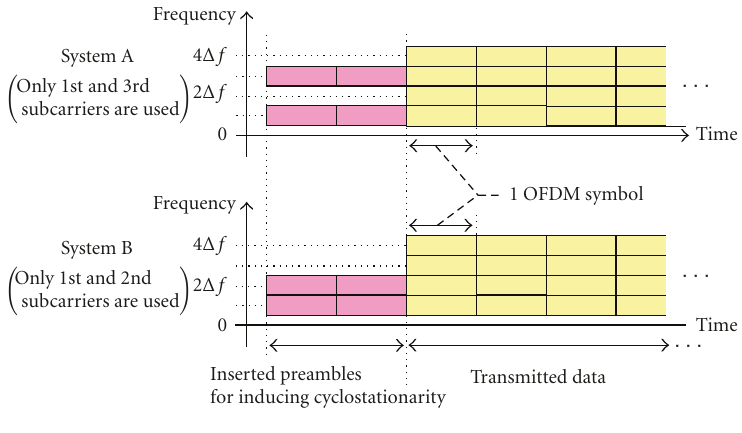
Figure 1: Illustration of frame format for Method A.